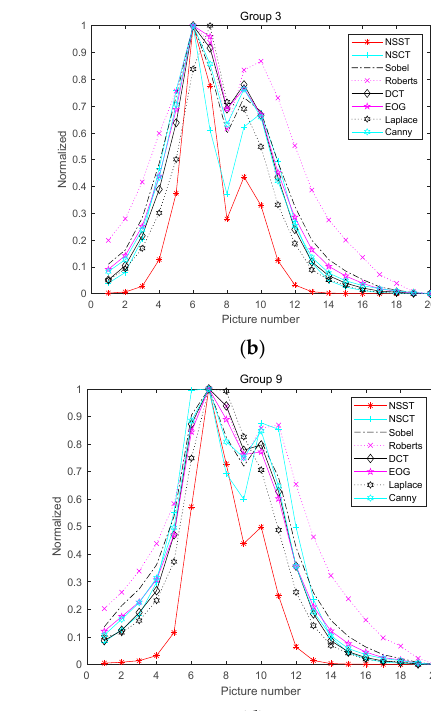
Figure 4. Four groups of test experiment diagrams: ( a ) Group 1; ( b ) Group 3; ( c ) Group 4; ( d ) Group